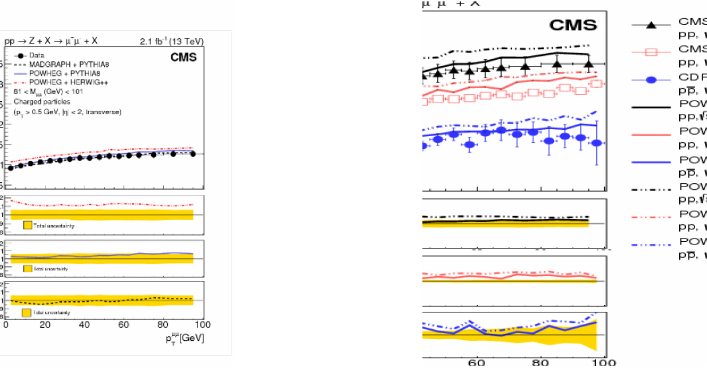
Fig. 7. Comparison of UE activity measured at (left) and Comparison of UE activity measured at and 1.96 TeV [15], by the CMS and CDF experiments for particle density in the transverse region as a function of 𝑇𝑇𝜇𝜇𝜇𝜇 𝑝𝑝